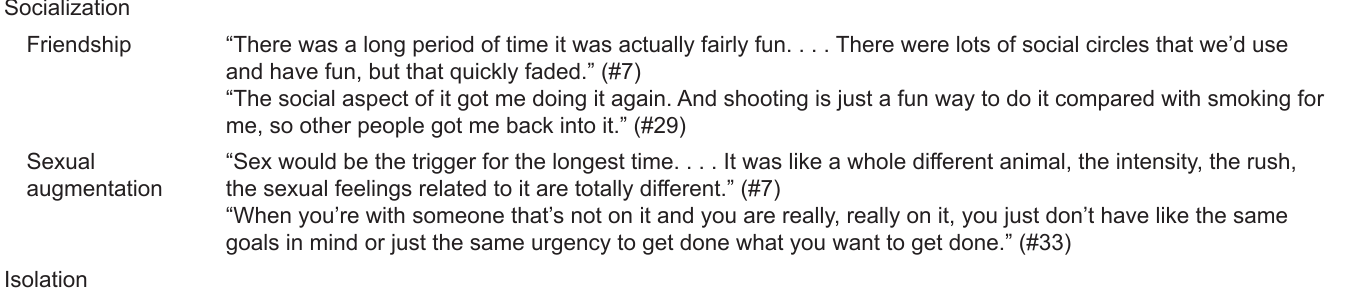
Table 4. Interviewee experiences that describe socialization and